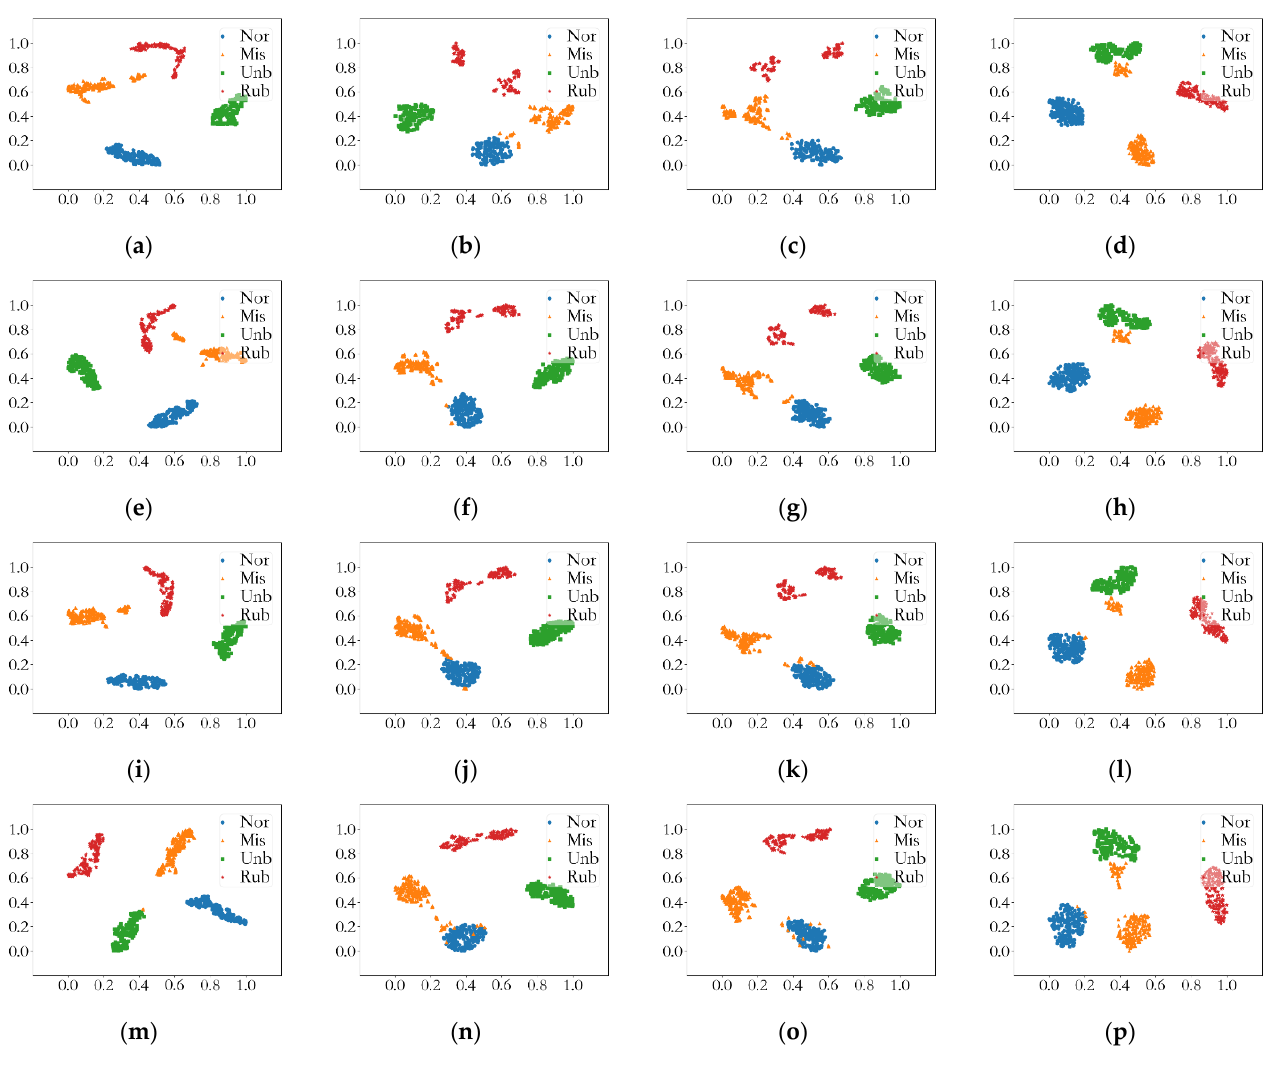
Figure 6. Distribution of signal characteristics under different noise: ( a ) IMFWPE visualization (without adding noise); ( b ) IMFPE visualization (without adding noise); ( c ) IMPE visualization (without adding noise); ( d ) MSE visualization (without adding noise); ( e ) IMFWPE visualization (SNR = 15 dB); ( f ) IMFPE visualization (SNR = 15 dB); ( g ) IMPE visualization (SNR = 15 dB); ( h ) MSE visualization (SNR = 15 dB); ( i ) IMFWPE visualization (SNR = 10 dB); ( j ) IMFPE visualization (SNR = 10 dB); ( k ) IMPE visualization(SNR = 10 dB); ( l ) MSE visualization(SNR = 10 dB); ( m ) IM- FWPE visualization (SNR = 5 dB); ( n ) IMFPE visualization (SNR = 5 dB); ( o ) IMPE visualization (SNR = 5 dB); ( p ) MSE visualization (SNR = 5 dB).